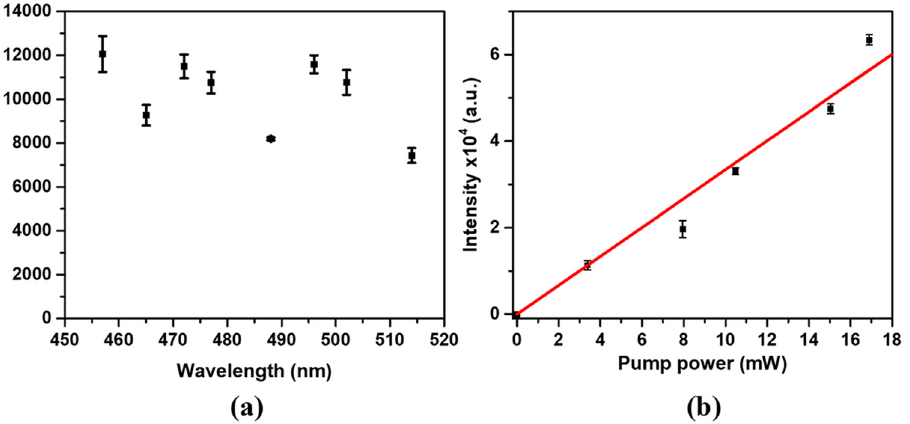
Figure 8: Intensity of down - conversion emission at 980 nm of phosphor NaY 0.88 F 4 :Yb 3 + 0.1 ,Tm 3 + 0.02 ( a ) versus the wavelength of the pump ( di ff erent spectral lines of Ar - ion laser ) and ( b ) versus the power of pump from Ar - ion laser spectral line at 465.8 nm. Solid red line is the linear fi t of the experimental